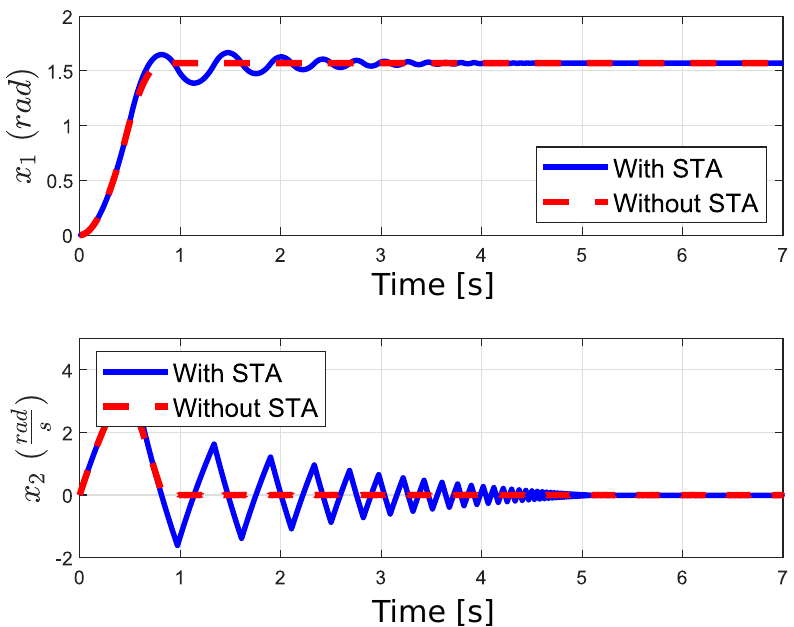
Figure 3. Pendulum system controlled with the bang − bang type controller with total access to the state vector (dotted line) and the velocity estimated by the super-twisting algorithm.